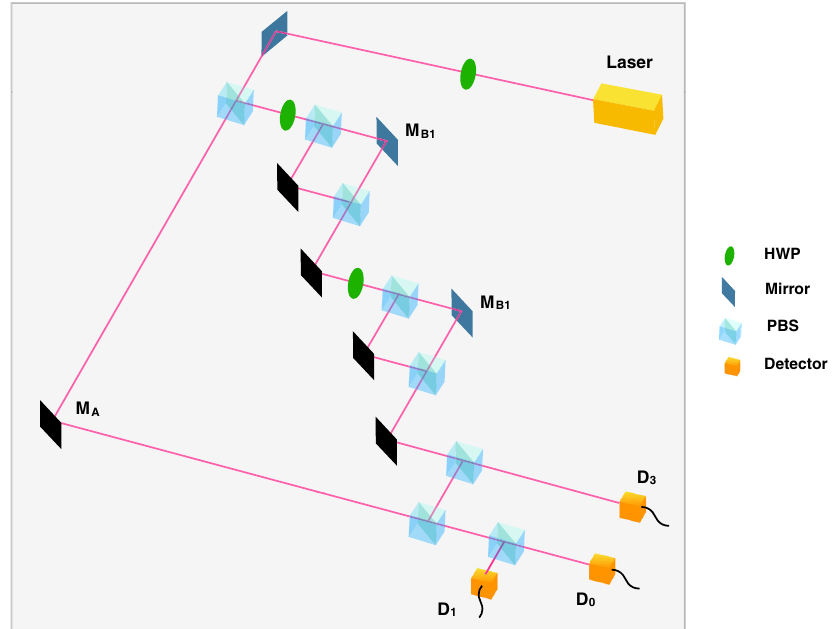
Fig. 2 3D depiction of experimental setup. This is based on the setup in Fig. 2. M A , M B 1 and M B 2 are MEMS mirrors oscillating at different frequencies. If a frequency associated with a given mirror is absent from the power spectrum at detector D 0 , then according to Vaidman ’ s weak trace approach, we know that photons detected at D 0 have not been near that